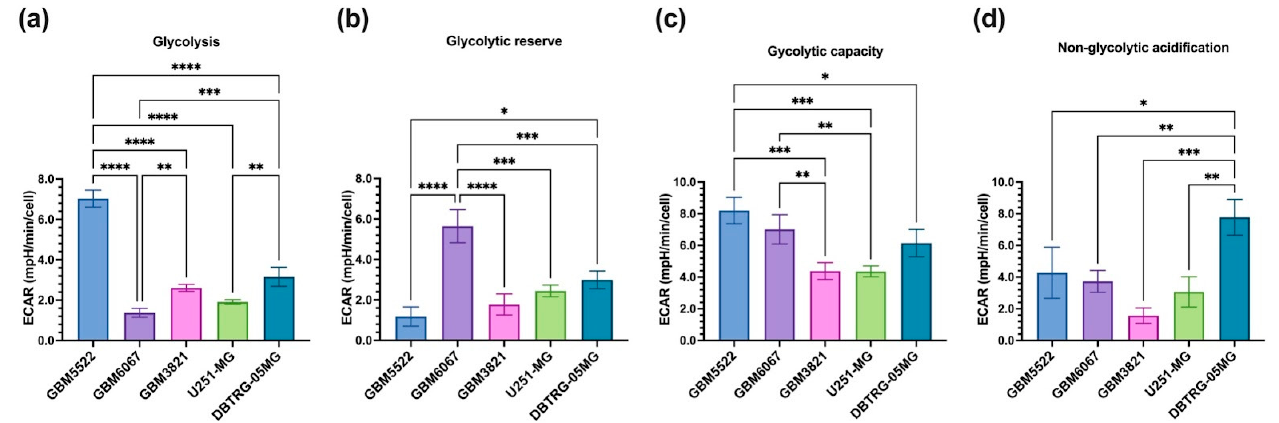
Figure 9. Enhanced oncolytic activity of CVB5 towards glioblastoma cell lines correlates with their glycolytic capacity. Basal glycolysis ( a ), glycolytic reserve ( b ) and maximum capacity ( c ) as well as non-glycolytic acidification ( d ) were assessed by the Seahorse technology in GlycoStress assay. Glucose was added to the final concentrations of 11 and 30 mM followed by addition of oligomycin (Oligo, 1 µ M), and 2DG (50 µ M). Values are means ± S.D, * p ≤ 0.05, ** p ≤ 0.01, *** p ≤